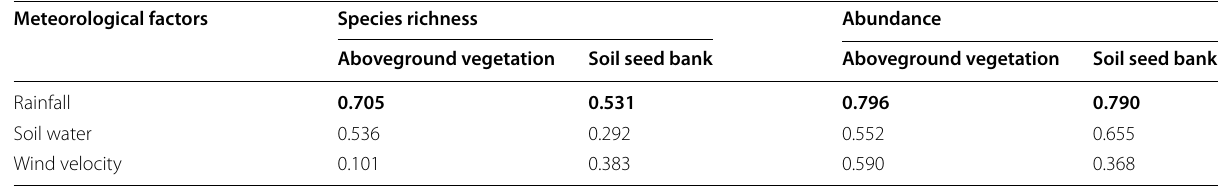
Bold font indicated the largest correlation coefficients for each response variable